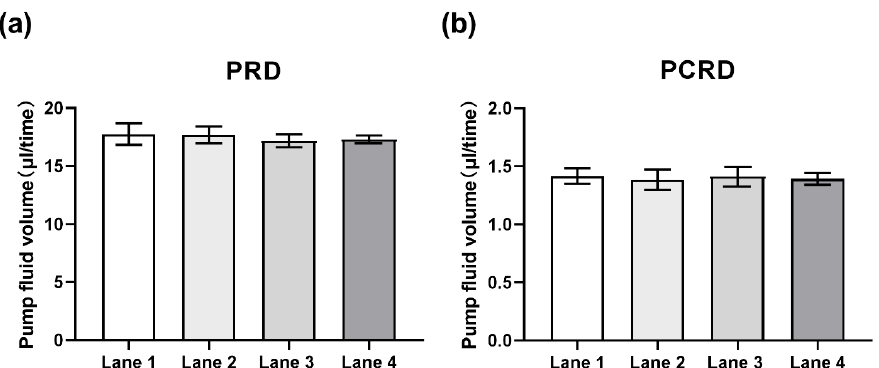
Figure 4. Characterization of pumping precision. ( a , b ) Under the preset working conditions (69 kPa, − 55 kPa, 10 Hz), the PRD and PCRD of each sample lane pumped liquid volume at one time. Error bars represent standard deviation ( n = 3).